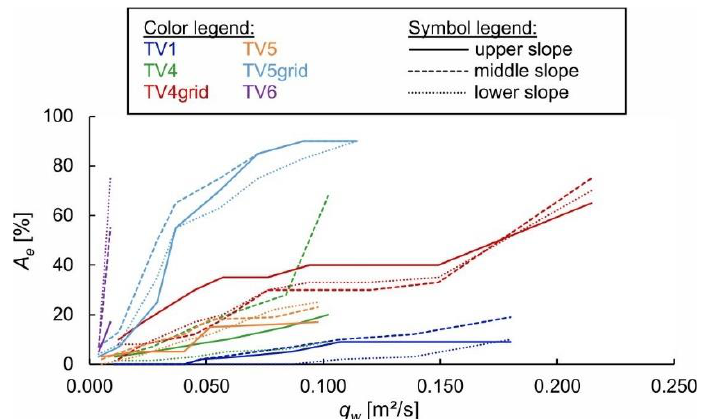
Figure 10. Percentage of eroded area A e along the 1:3 slope as function of the overflow rate q w for different vegetated covers. TV1 = species‐poor grass‐dominated mixture, TV4 = grass-herb mixture, di ff erent vegetated covers. TV1 = species-poor grass-dominated mixture, TV4 = grass-herb mixture, TV5 = species‐rich herb‐dominated EcoDike mixture, TV6 = species-rich herb-dominated ready-mix, TV5 = species-rich herb-dominated EcoDike mixture, TV6 = species-rich herb-dominated ready-mix, and grid = geogrid reinforcement. and grid = geogrid